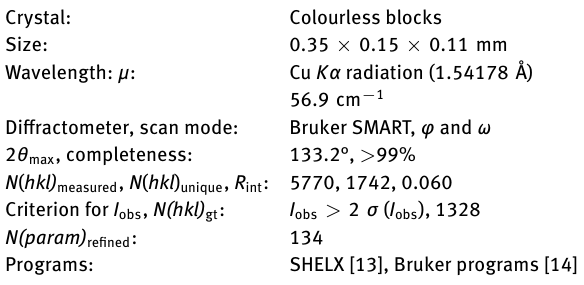
Table 2: Fractional atomic coordinates and isotropic or